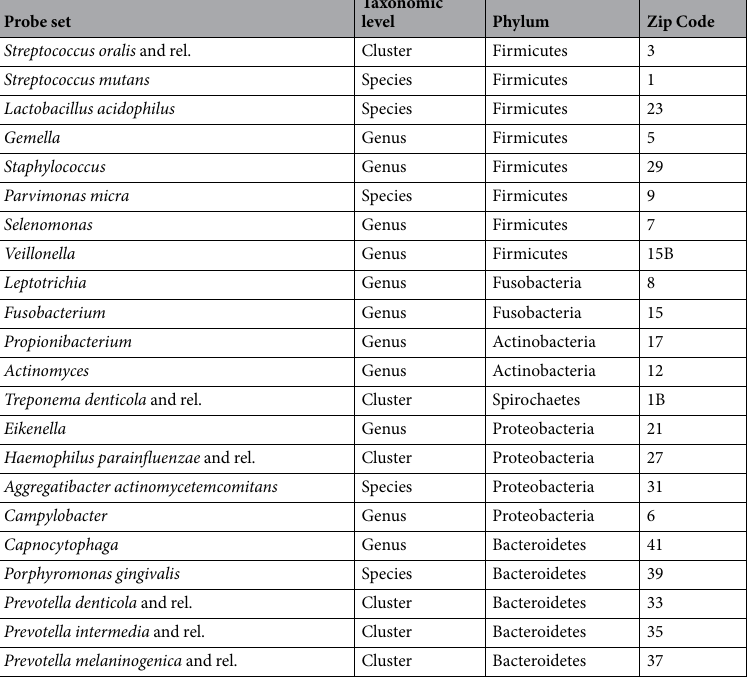
Table 1. Bacterial targets of the OralArray, the taxonomic level, the phylogenetic classification and the Zip Code associated in the